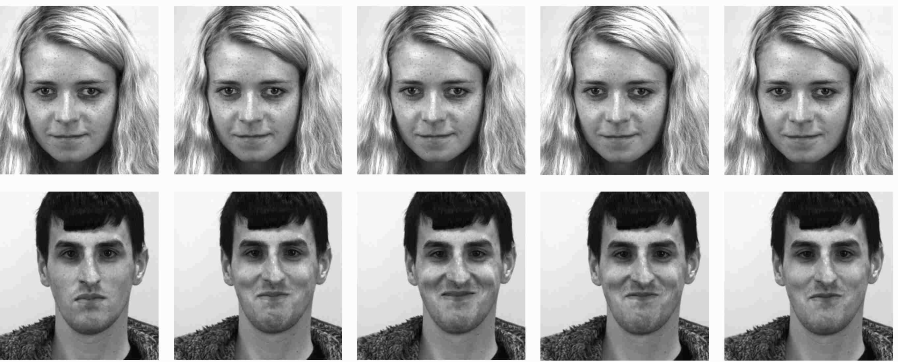
Figure 1. Microexpressions ( top ) and macroexpressions ( bottom ) are qualitatively identical but the former are involuntary and much shorter in expression than the